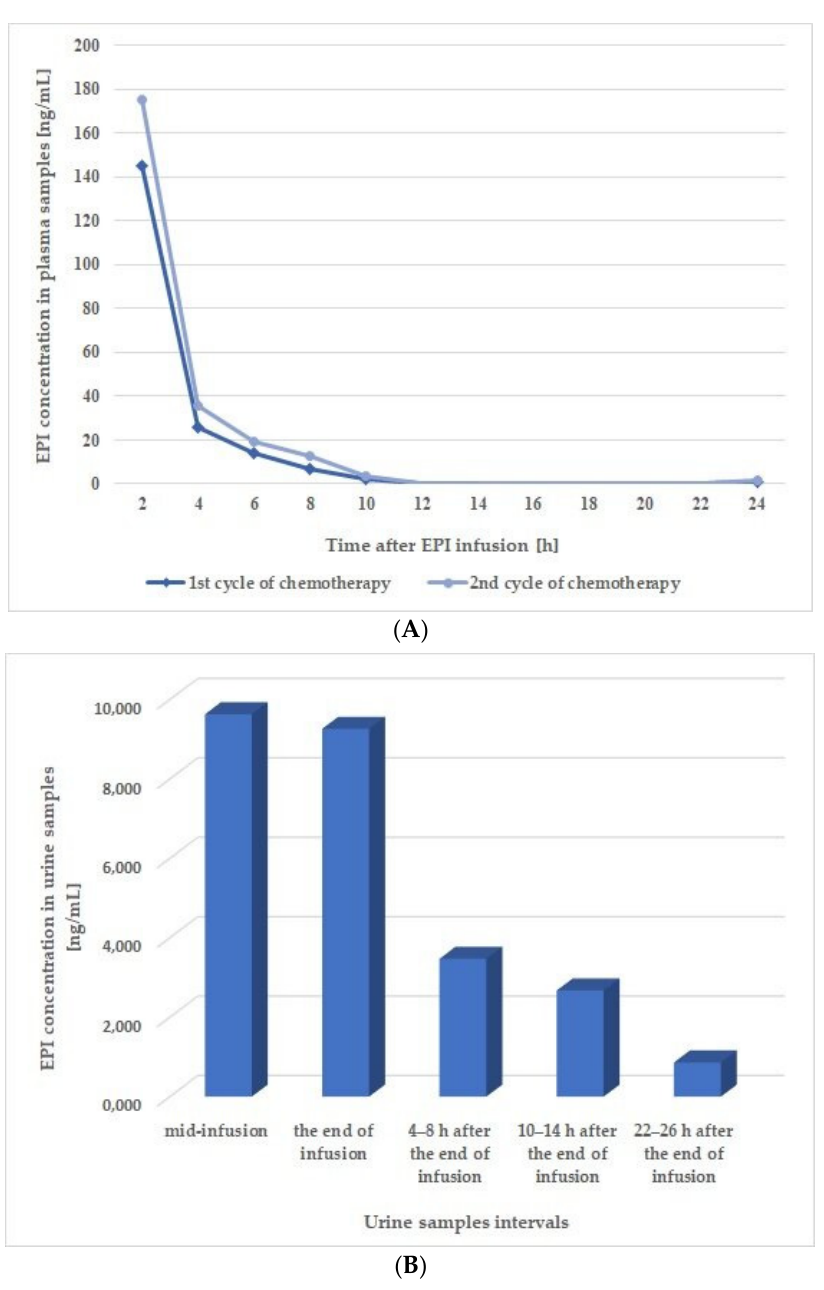
Figure 3. Concentration time profiles of EPI in ( A ) plasma and ( B ) urine samples from a patient receiving this drug at a dose of 150 mg/m 2 via a 6 h intravenous infusion.